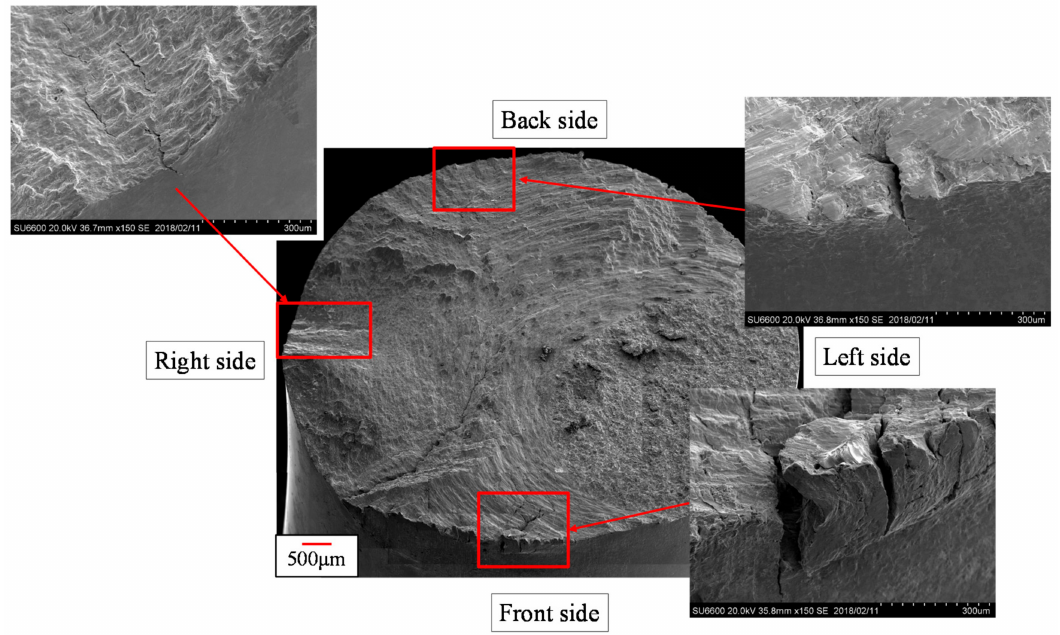
Figure 14. Fracture surface observation results according to the type of specimen, following the CT test at 112 MPa of equivalent stress